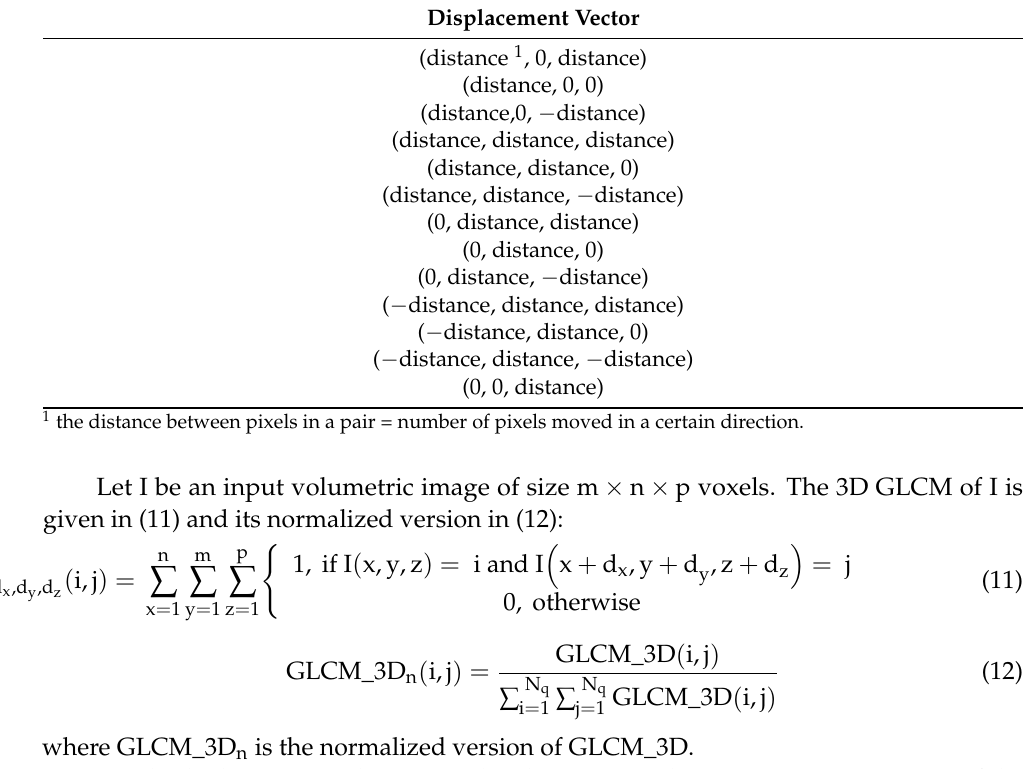
Table 2. Displacement vectors for 3D